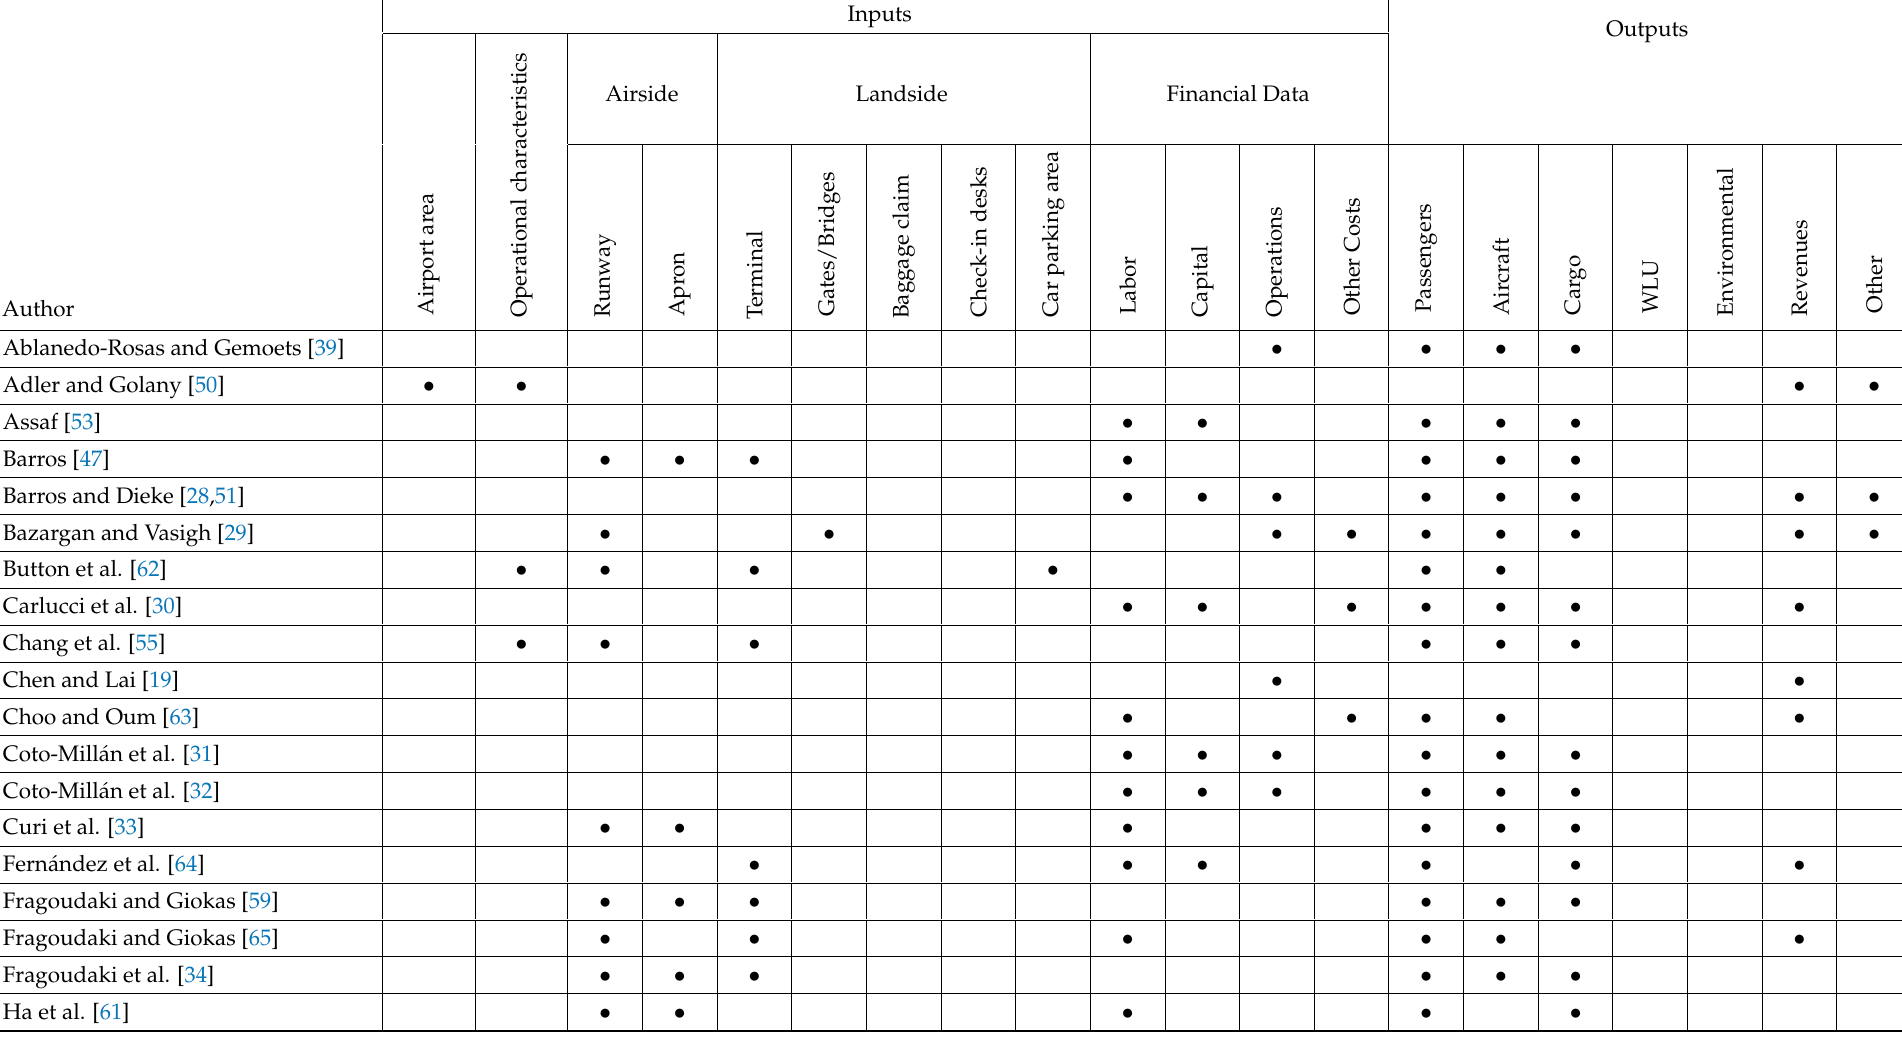
Table 1. Review of the inputs and outputs used in DEA